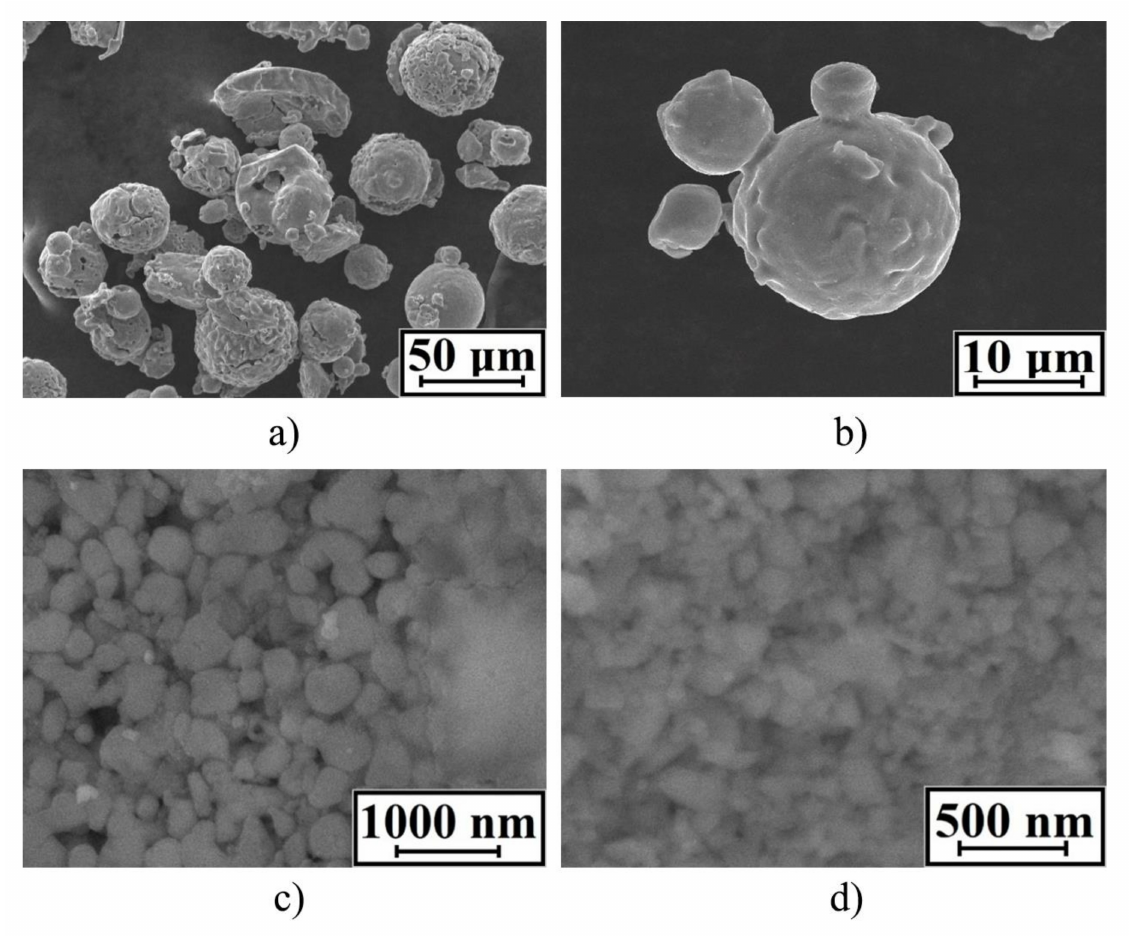
Figure 5. SEM of iron samples: m–Fe_01 ( a ); m–Fe_02 ( b ); n–Fe_01 ( c ); n–Fe_02 ( d ). Figure 6 demonstrates the weight change of the samples during heating in a hydrogen atmosphere. As can be seen, in the case of m-Fe_01, m–Fe_02, n–Fe_01, and n-Fe_02 samples, the weight change was insignificant, which was associated with a high content of metallic iron. In the remaining samples, the beginning of active weight loss was